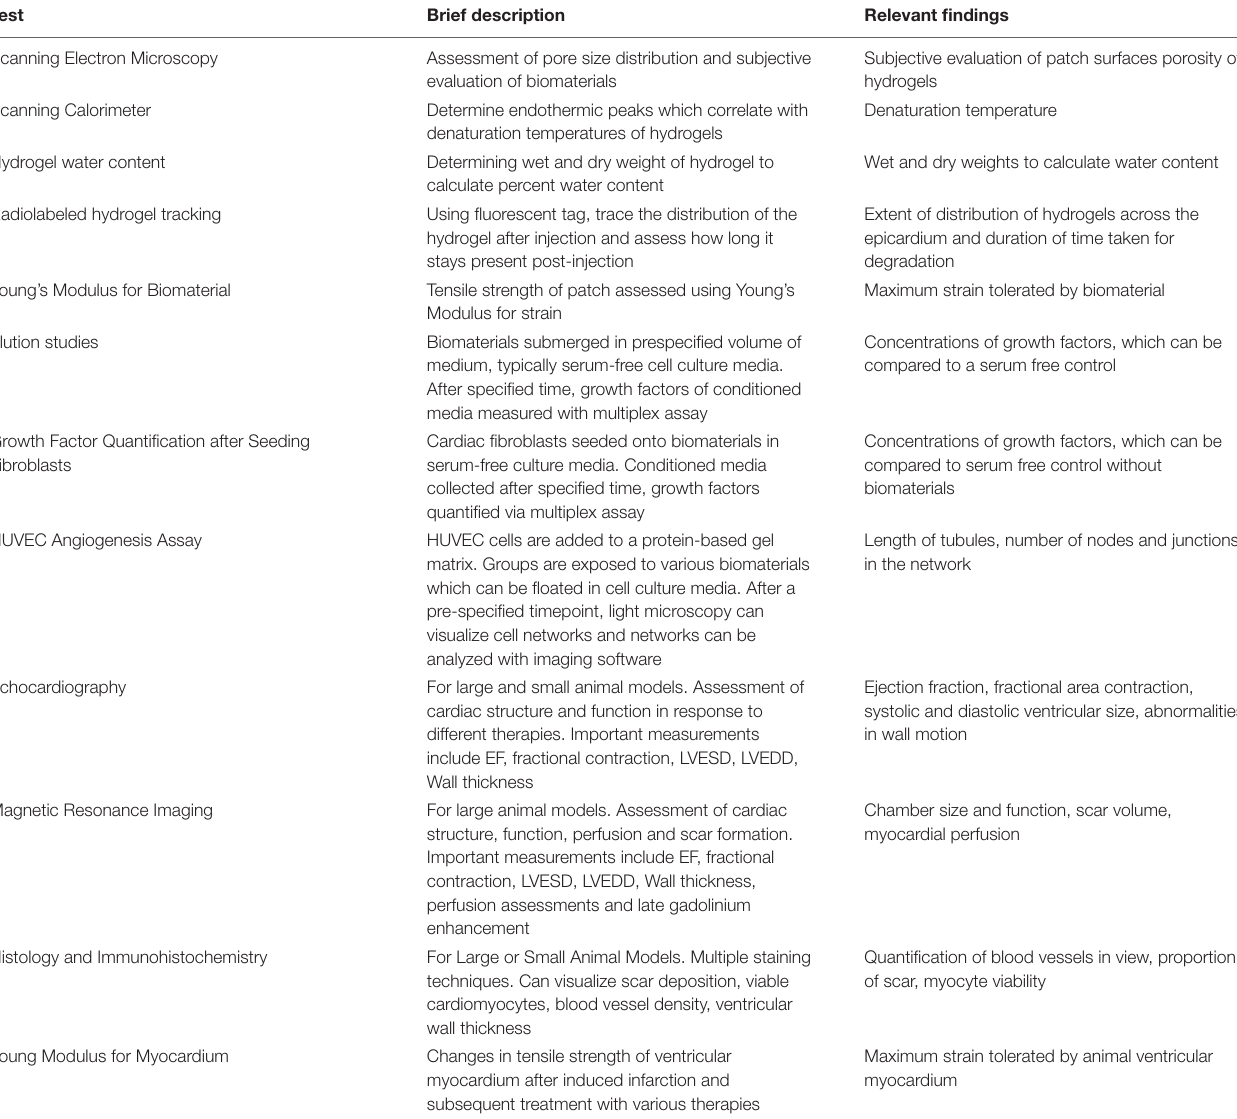
TABLE 1 | Preclinical evaluation modalities for